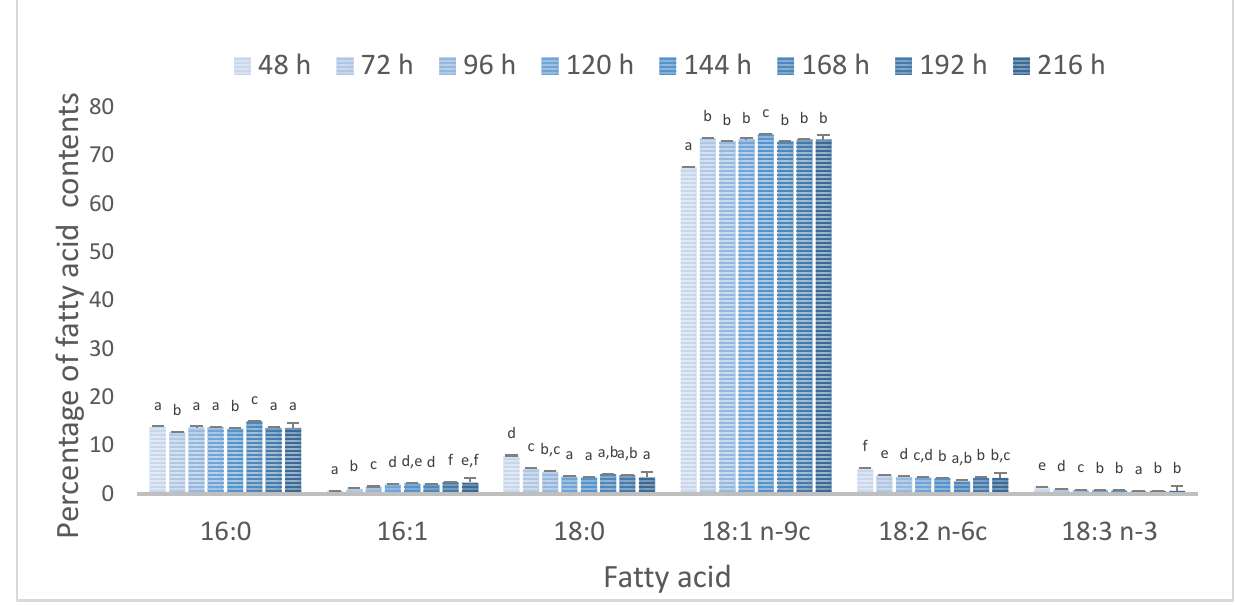
Figure 6. Dependence between main fatty acids composition and the time of incubation during fed-batch B at 20 °C. a – f Values with different superscripts for specific fatty acid within a column are significantly different at p < 0.05 (one-way ANOVA analysis).